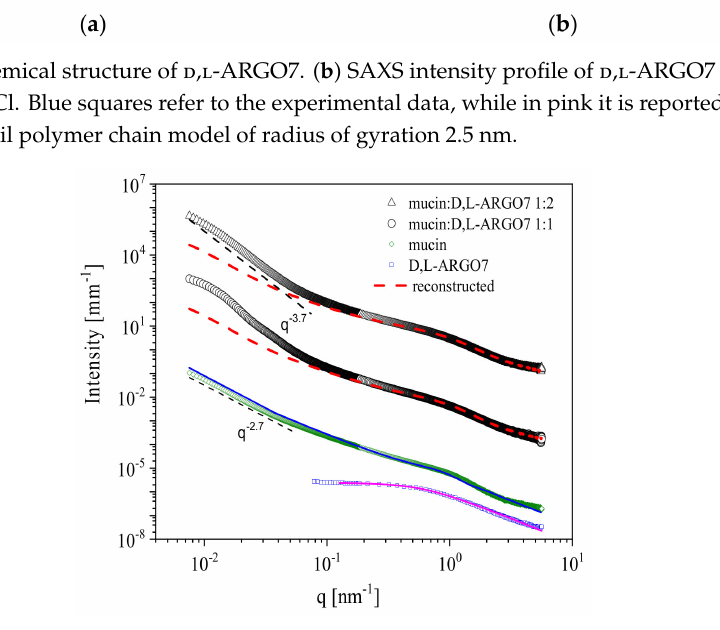
Figure 2. SAXS intensity profiles of the individual d , l -ARGO7 polymer and PGM mucin and of PGM / d , l -ARGO7 mixed solutions at pH = 6.8 and 135 mM NaCl. From top: 1:2 weight ratio, black triangles not rescaled [in absolute units], and 1:1 polymer / mucin ratio, black circles, rescaled × 10 − 3 , bare PGM (10 mg / mL) in bu ff er with fit (blue line) according to dumbbell-like shape form factor [23–25], green diamonds, rescaled × 2 × 10 − 3 ; and d , l -ARGO7 (10 mg / mL), blue squares rescaled × 2 × 10 − 4 , with fit (pink line) by a Gaussian coil polymer chain model of radius of gyration 2.5 nm. Red lines represent the profiles reconstructed by summing the two components according to weight